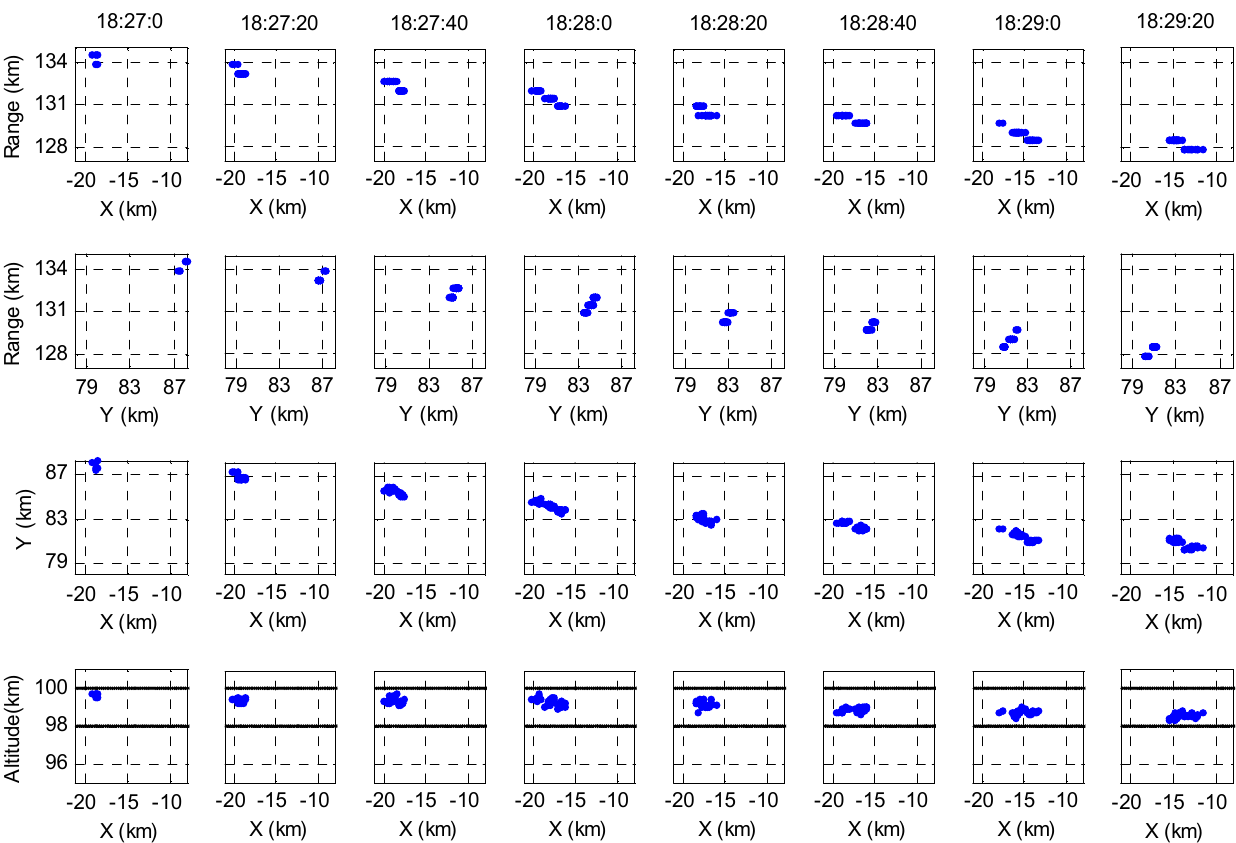
Fig. 4. Series of three-dimensional distribution of the striation number 8 (Fig. 3) of the QP echoes, observed by the interferometry technique. The data start at 18:27:00 and end at 18:29:20 LT on 3 July 2000. The first two panels display the range vs. the x- and y- axes, respectively. The third panels display the motion projected in the x–y plane. The bottom panel shows the altitude vs. the x-axis.